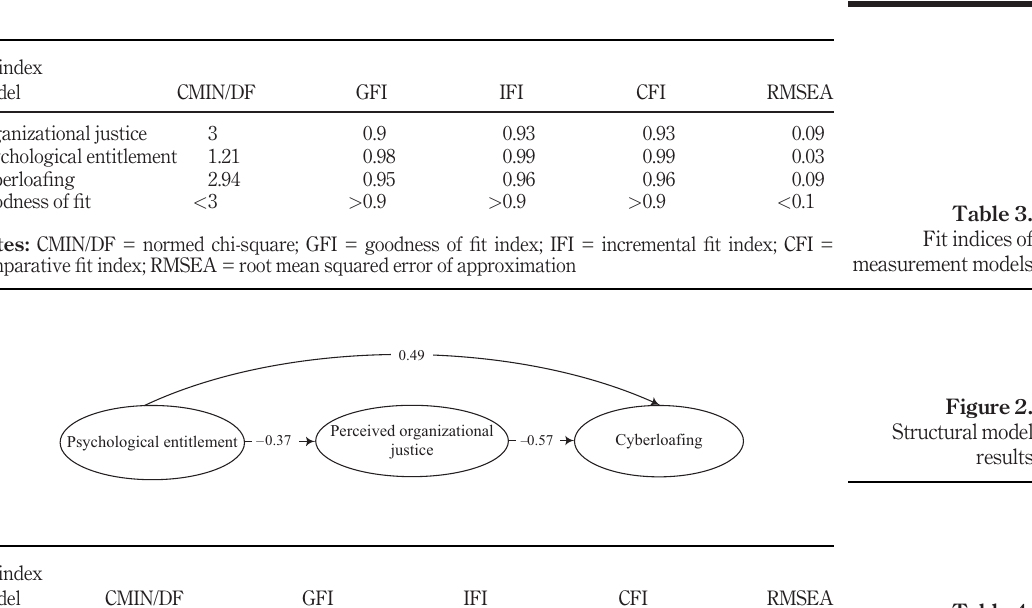
Table 4. Fit indices of the